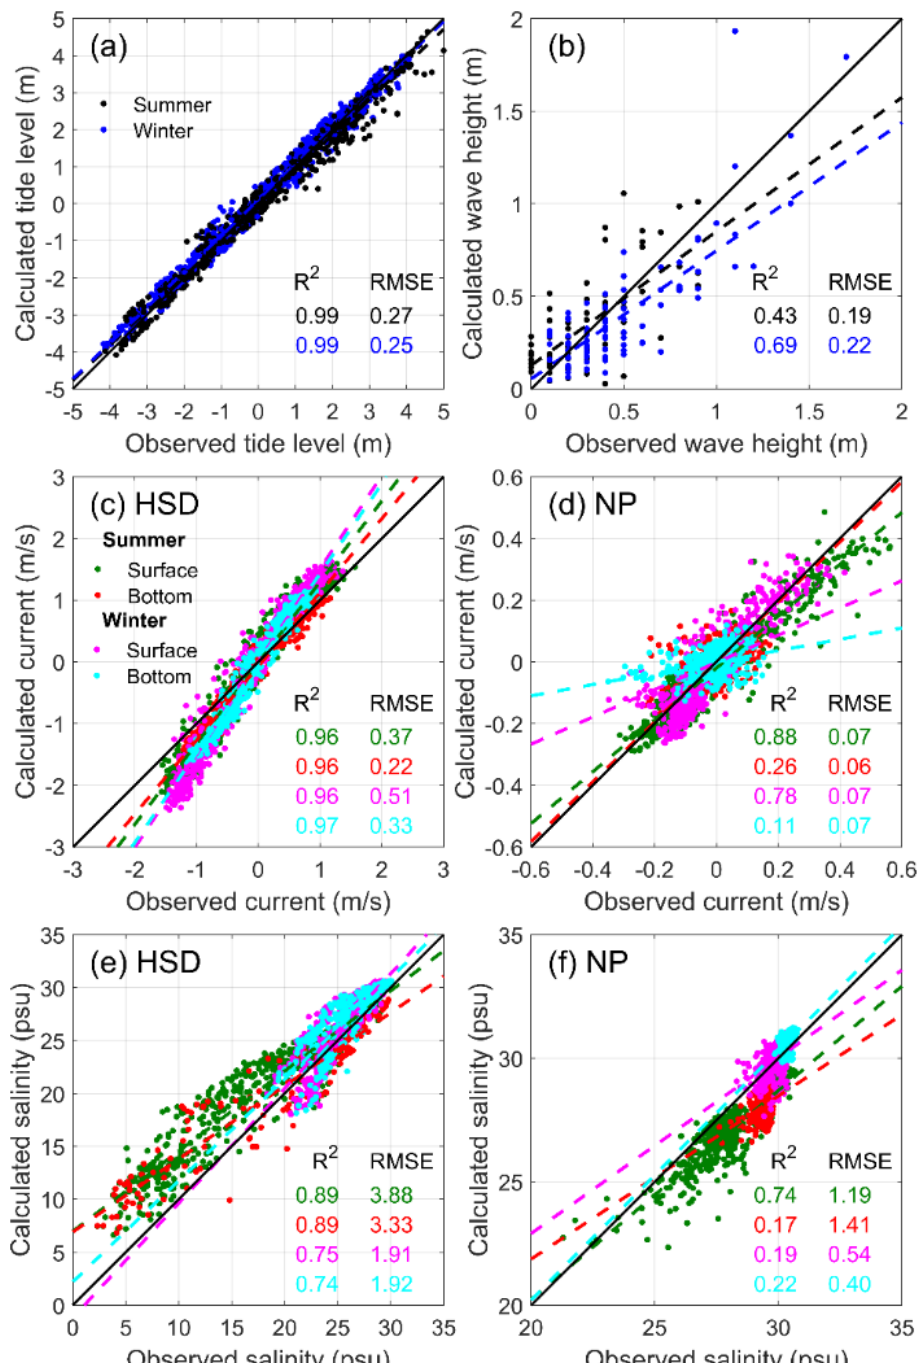
Figure 4. Comparison between observations and the model results. ( a ) Tide levels at 7 stations; ( b ) significant wave heights at DJD; ( c , d ) velocities observed from ADCP at HSD and NP; and ( e , f ) Salinity observed from CTD at HSD and NP.